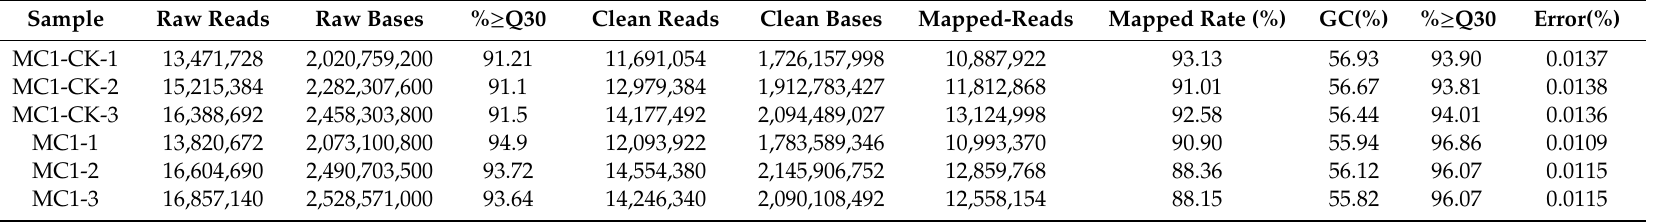
Table 1. Summary of the transcriptome assembly of strain MC1. Control (CK 0M) and salt-treated (1.7 M) raw read